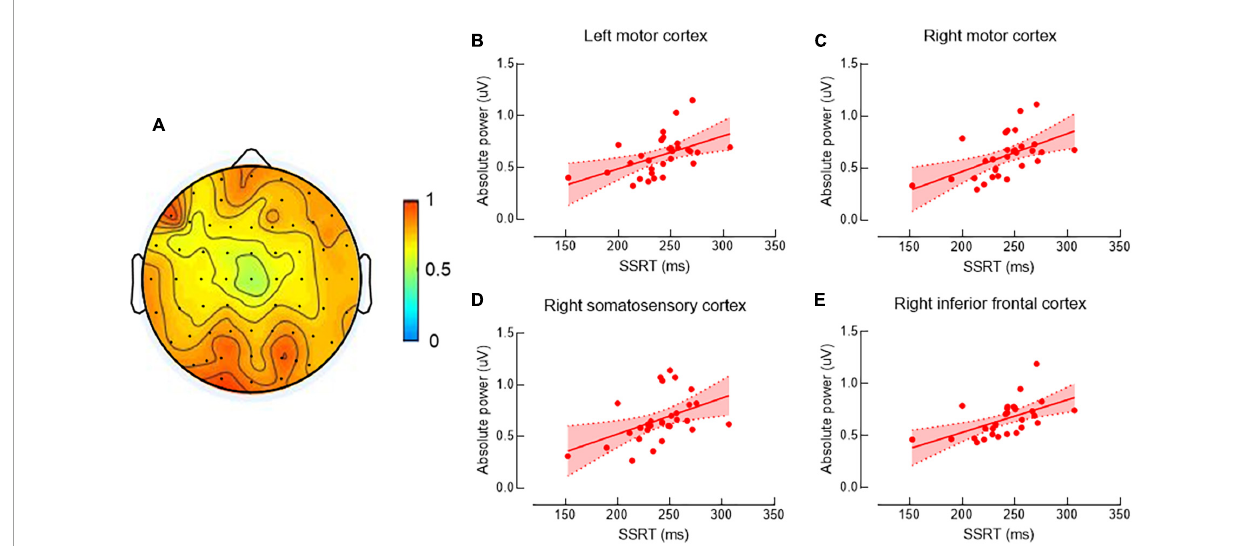
FIGURE1 Correlations between beta band power and stop-signal reaction time (SSRT). The topographic map shows beta band power (A) . Data are presented as raw values of power. Scatter plots show the significant positive correlations between SSRT and beta band power in left motor cortex (MC) (B) , right MC (C) , right motor somatosensory cortex (SC) (D) , and right inferior frontal cortex (IFC) (E) . As longer SSRT is associated with more poor ability of response inhibition, individuals with poor ability of response inhibition tended to have greater electroencephalography (EEG) power in the above brain regions.